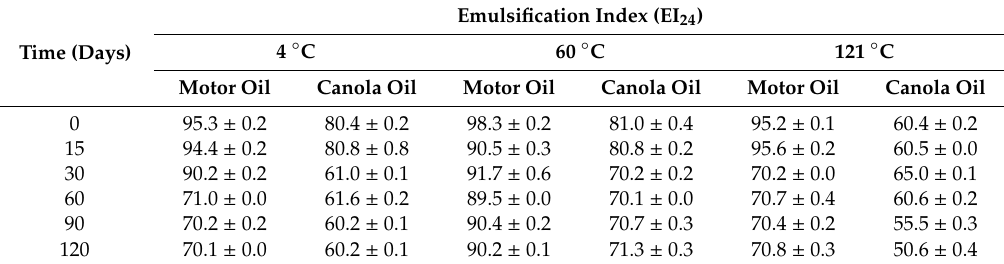
Table 7. Motor oil and canola oil emulsification stability for 120 days on di ff erent temperatures treatments (data expressed as mean ± standard